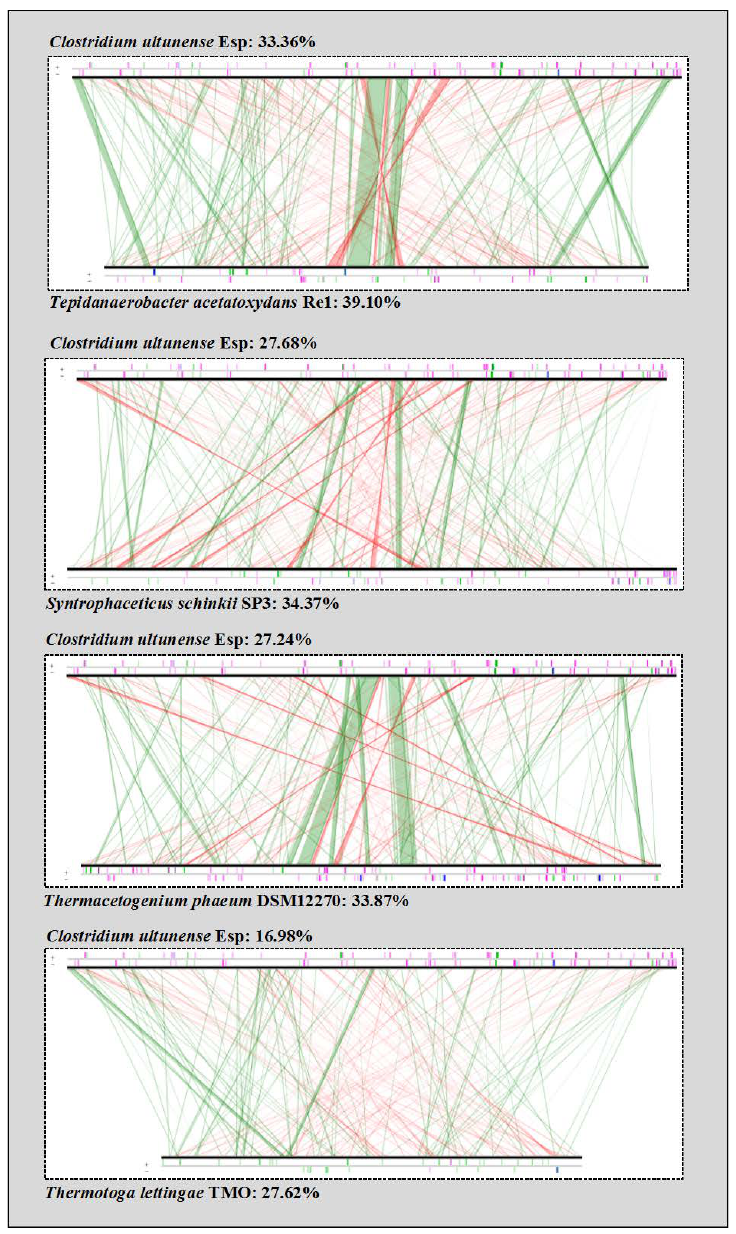
Figure 2. Synteny comparison of C. ultunense strain Esp and the SAOB S. schinkii , T. acetatoxydans , Th. phaeum , and P. lettingae. The lines indicate syntons between two genomes. Red lines show inversions around the origin of replication. Vertical bars on the border line indicate different elements in genomes, where pink = transposases, or insertion sequences, blue = rRNA and green = transfer RNA